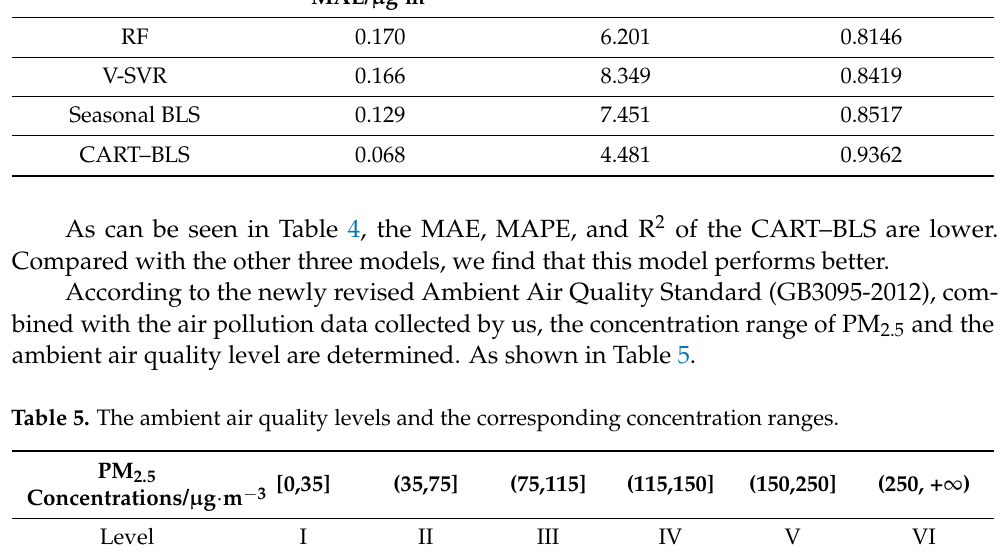
Table 4. Comparison of MAE, MAPE, and R 2 of different models. Model